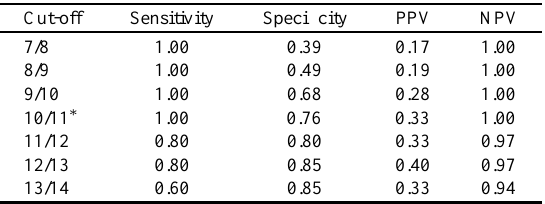
Table 3 Sensitivity, specificity, positive and negative predictive values at dif- ferent cut-off scores for the Geriatric Depression Scale Cut-off